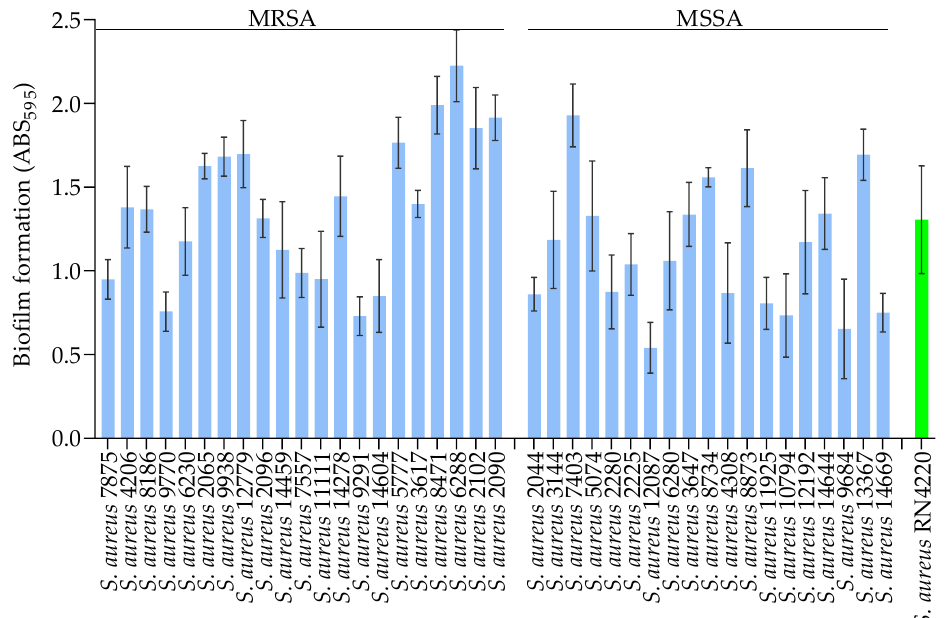
Figure 2. Biofilm formation (ABS 595 ) of MRSA and MSSA strains grown in TSB supplemented with 1.0% glucose. The green bar shows results for the positive control strain RN4220. The data show the mean, and error bars represent the standard deviation within the replicates, for at least two independent experiments.